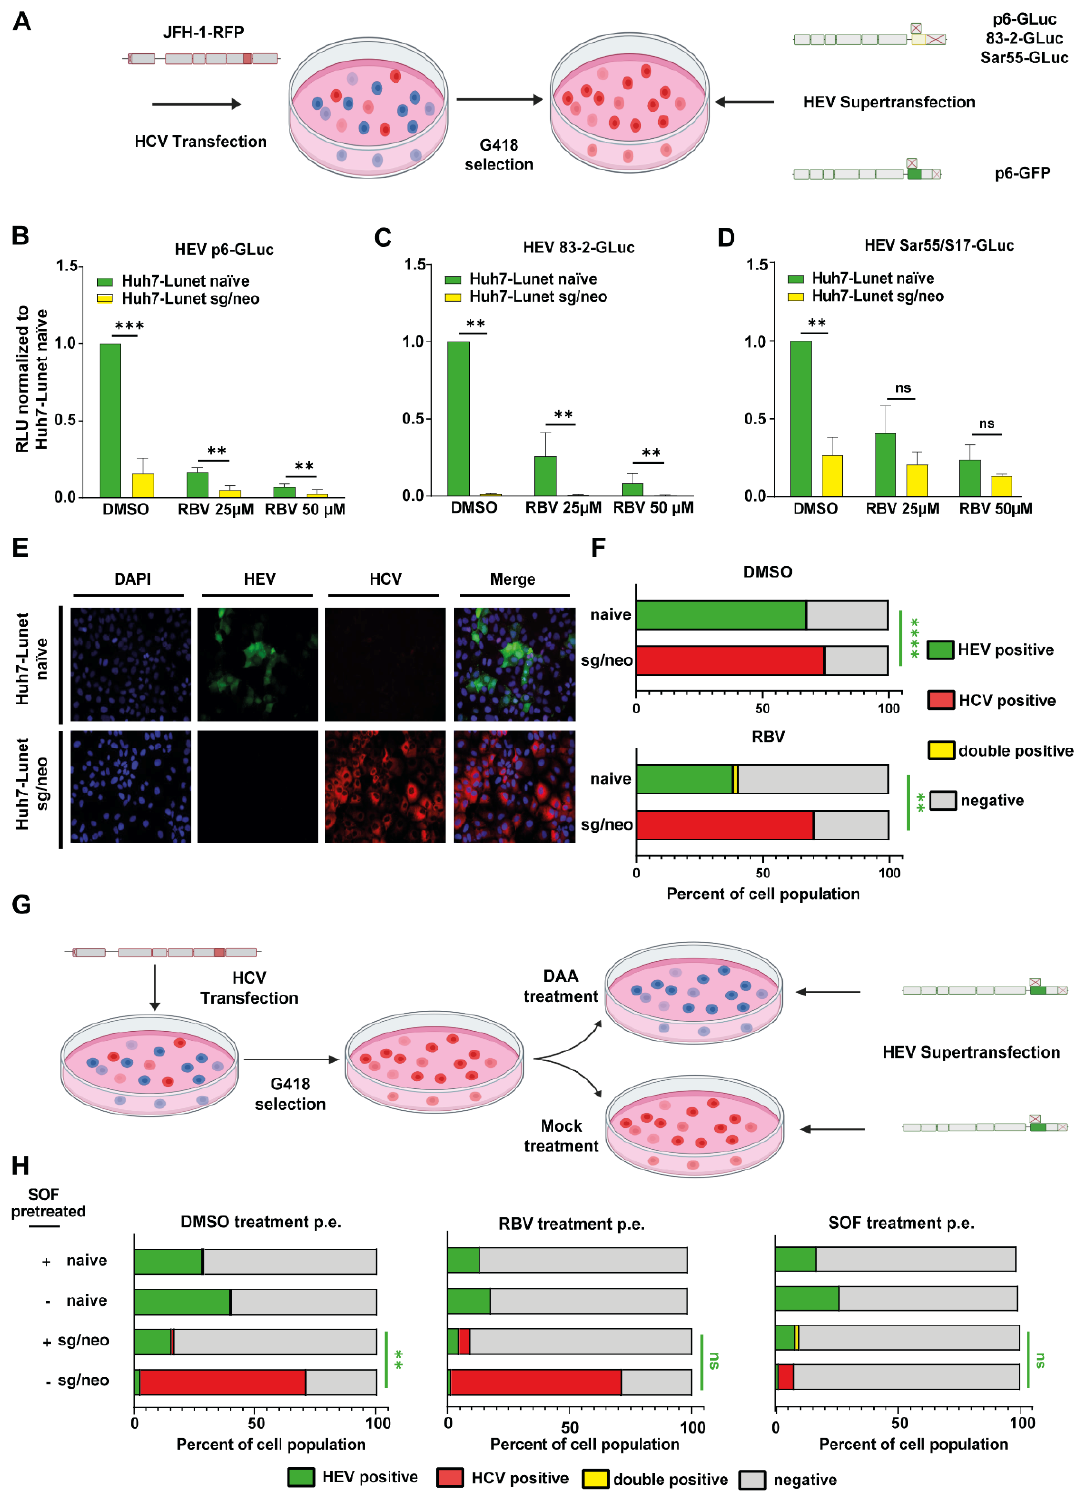
Figure 3. HEV replication in HCV-selected human hepatocytes. ( A ) Schematic representation of experimental setup for panels ( B – F ). Huh7 cells were transfected with a selectable HCV subgenomic replicon expressing RFP, JFH1-NS5A-RFP, and selected and subsequently transfected with either an HEV luciferase reporter or GFP reporter subgenomic replicon. G418 treatment was discontinued upon transfection to rule out unspecific effects on HEV. ( B – D ) Replication of HEV replicons 72 h post electroporation was assessed in naïve Huh7-Lunet cells or Huh7-Lunet cells expressing the selectable HCV subgenomic replicon (Huh7-Lunet/sg-neo). Cells were incubated with DMSO or ribavirin (RBV). Treatment was started 4 h post electroporation. Depicted are means ± SD from three independent experiments. (Two-way ANOVA with Sidak’s multiple comparison test). ( E ) Repre- sentative IF pictures of Huh7-Lunet naïve (upper panel) or Huh7-Lunet/sg-neo cells (lower panel) transfected with a HEV p6-GFP subgenomic reporter replicon, imaged 5 days post electroporation. ( F ) Percentage of Huh7-Lunet naïve or Huh7-Lunet/sg-neo cells positive for HCV, HEV, both or none, as determined by flow cytometry 5 days post electroporation. Cells were treated with DMSO